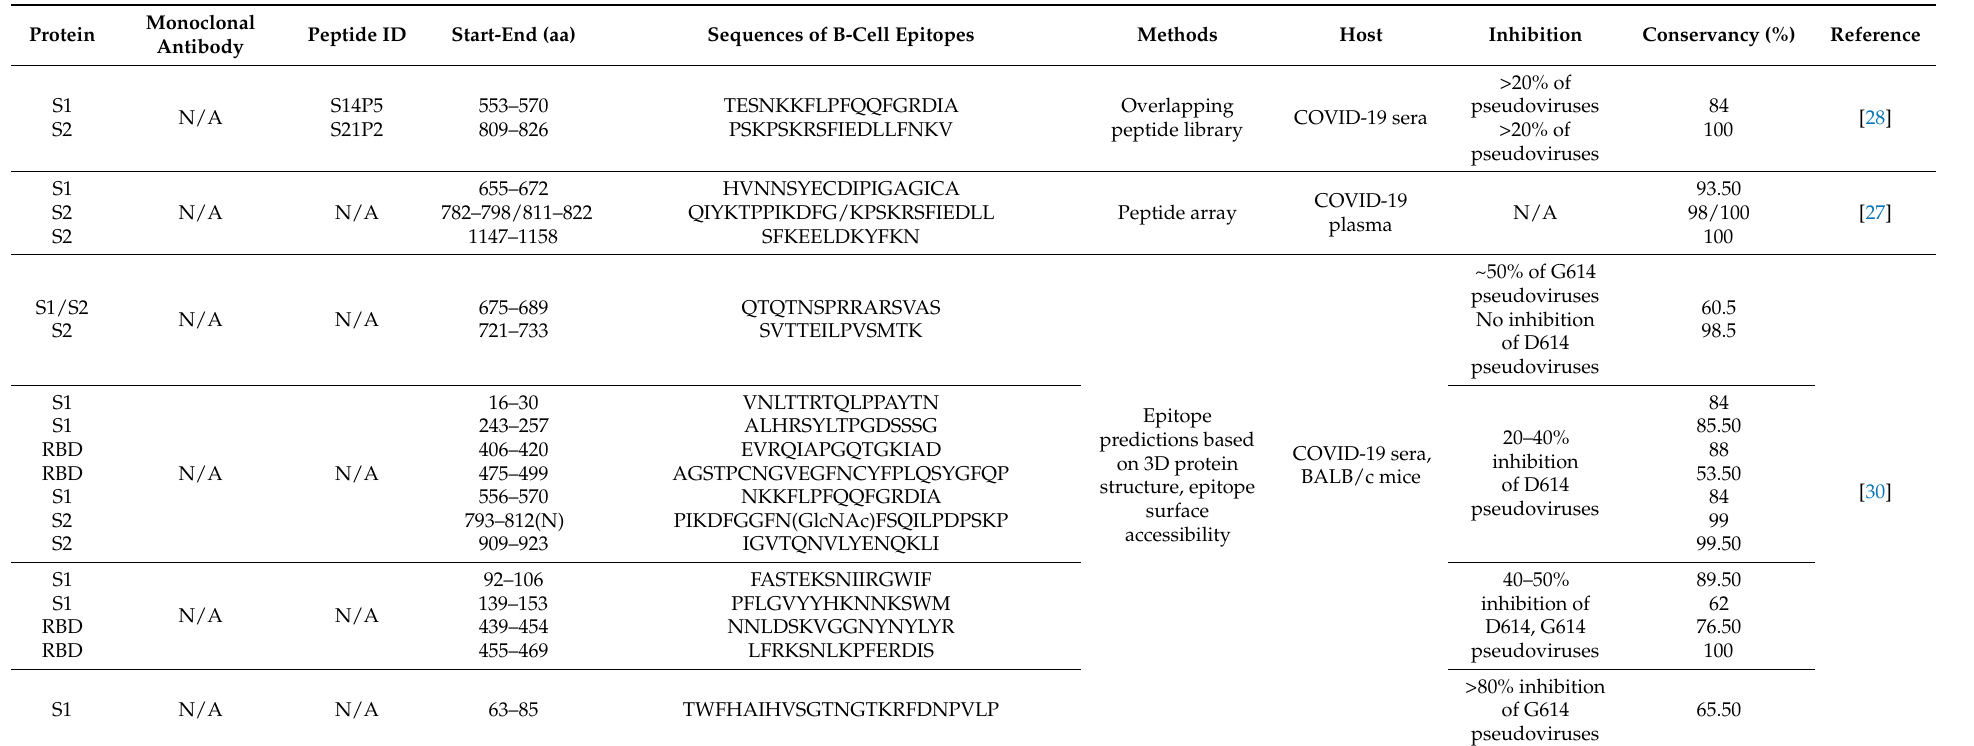
Table 2. Peptides specifying B-cell epitopes identified in